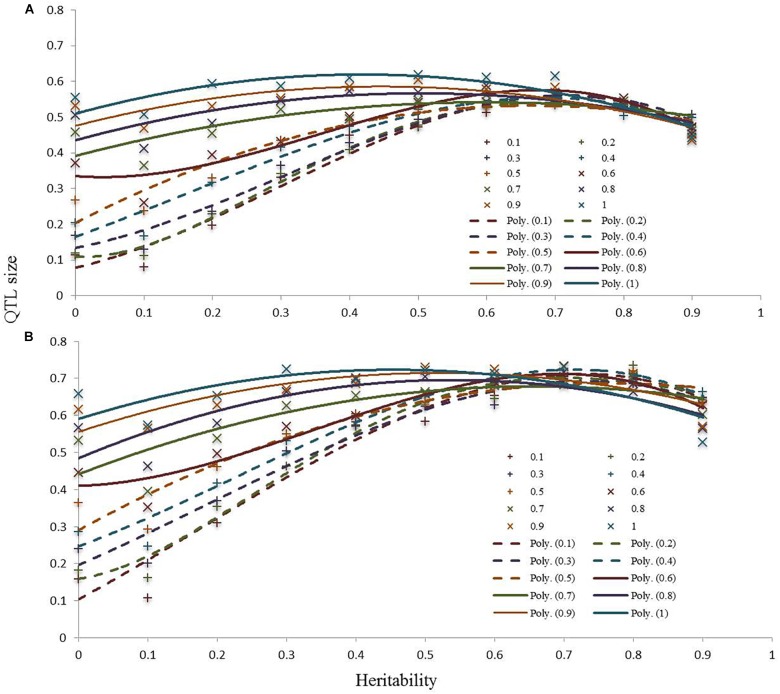
Computer simulations at 250 kb (A) and 500 kb (B) to determine the power of detection of QTLs.